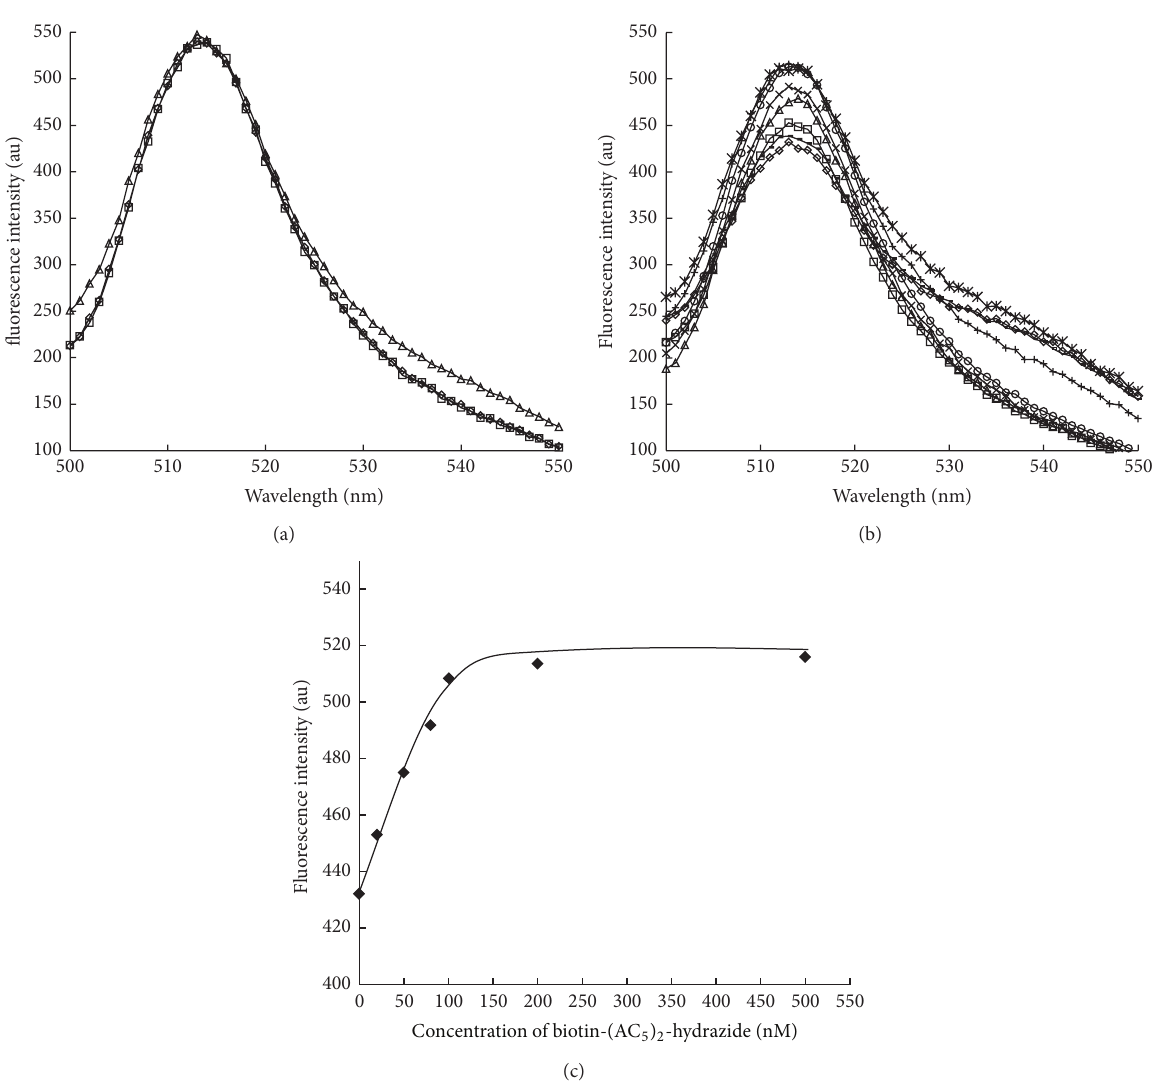
Figure 3: (a) Fluorescence spectrum of the Tyr83BFLAF mutant streptavidin only (– ⃝ –); fluorescence spectrum of the Tyr83BFLAF mutant streptavidin in the presence of 100 nM of natural biotin (– 󳵻 –) or 100 nM of biotin-(AC 5 ) 2 -hydrazide (– ◻ –); there was no change in the fluorescence intensity (au) upon addition of natural biotin or biotin-(AC 5 ) 2 -hydrazide for Tyr83BFLAF mutant streptavidin. (b) Fluorescence spectra of the Trp120BFLAF mutant streptavidin only (– ◊ –), in the presence of 100nM of biotin (– ◼ –), 20 nM (– ◻ –), 50 nM (– 󳵻 –), 80nM (– × –), 100 nM (– ∗ –), 200nM (– ⃝ –), or 500 nM (–+–) of biotin-(AC 5 ) 2 -hydrazide. Marked fluorescence enhancement was observed for the Trp120BFLAFmutantstreptavidinbyadditionofbiotin-(AC 5 ) 2 -hydrazide.(c)DependenceofthefluorescenceenhancementofTrp120BFLAF mutant streptavidin on the concentration of added biotin-(AC 5 ) 2 -hydrazide (20nM to 100 nM) was observed. The fluorescence intensities of the Trp120BFLAF mutant streptavidins in the presence of various concentration of biotin-(AC 5 ) 2 -hydrazide at 514 nm were plotted. All of the fluorescence spectra of mutant streptavidins were excited at 490